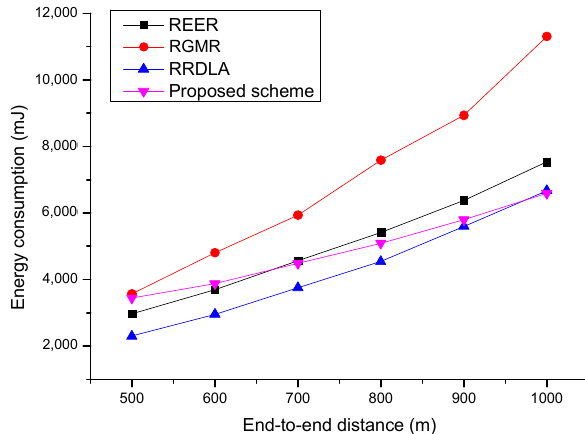
Figure 8. Average energy consumption vs. end-to-end distance with for 90% of the link reliability.